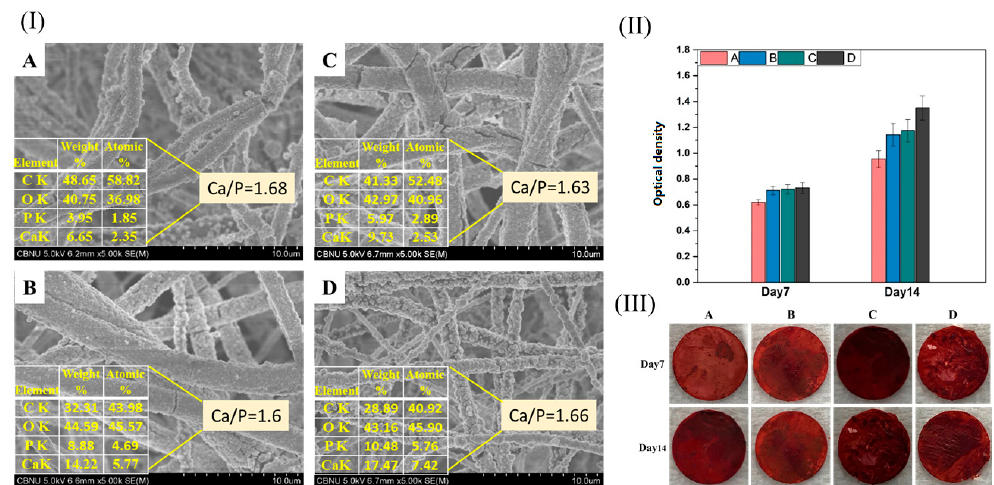
Figure 3. ( I ) SEM images and inset tables of EDS analysis after incubation in SBF solution for 10 days. ( II ) Absorbance shown by Alizarin Red S extracted from the stained calcium deposits on the surface of different nanofibrous mats treated with SBF solution. ( III ) The inset shows selected digital images of different nanofibrous mats. ( A ) PCL, ( B ) PCL-PGS, ( C ) PCL-PGS-HA, ( D ) PCL-PGS-HA-SIM.